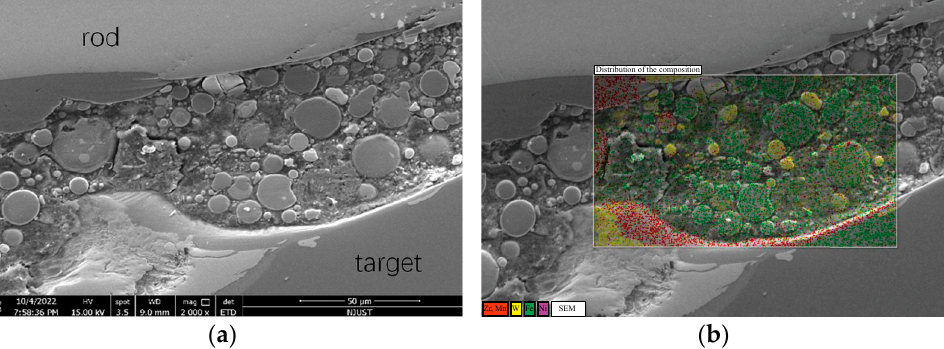
Figure 9. SEM image of the interface of the rod and target. ( a ) SEM image of the interface; ( b ) Composition of the material.